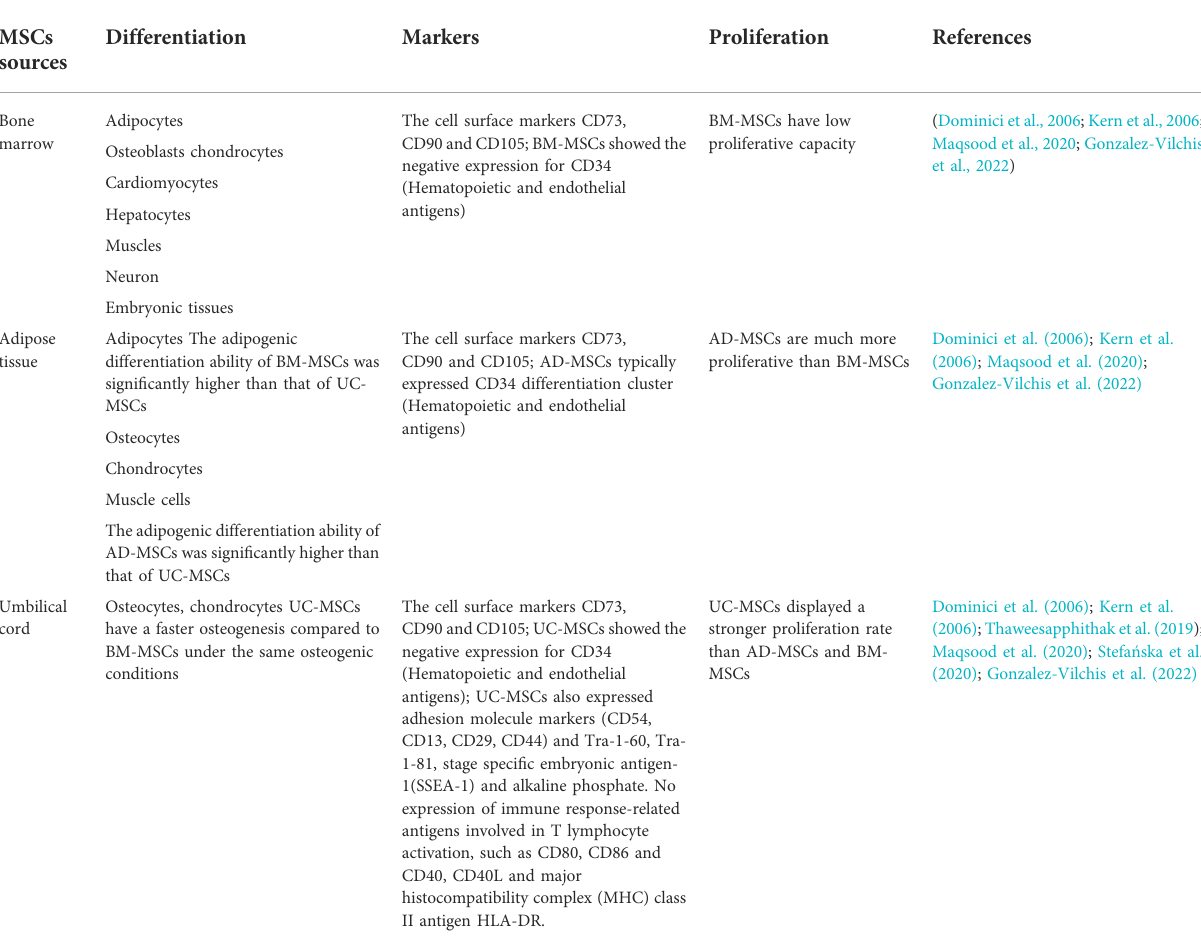
TABLE 1 Characteristics of MSCs from different